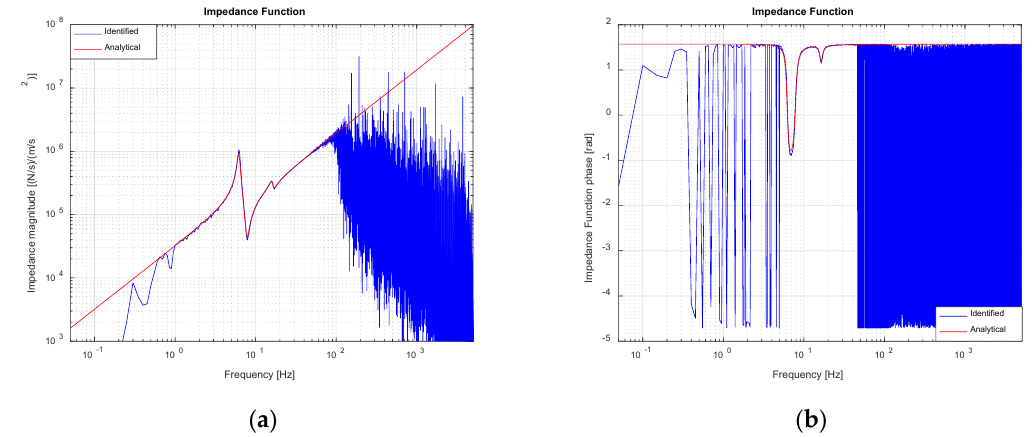
Figure 12. Identified and analytical IF (noise-contaminated scenario): ( a ) Magnitude; ( b ) Phase.